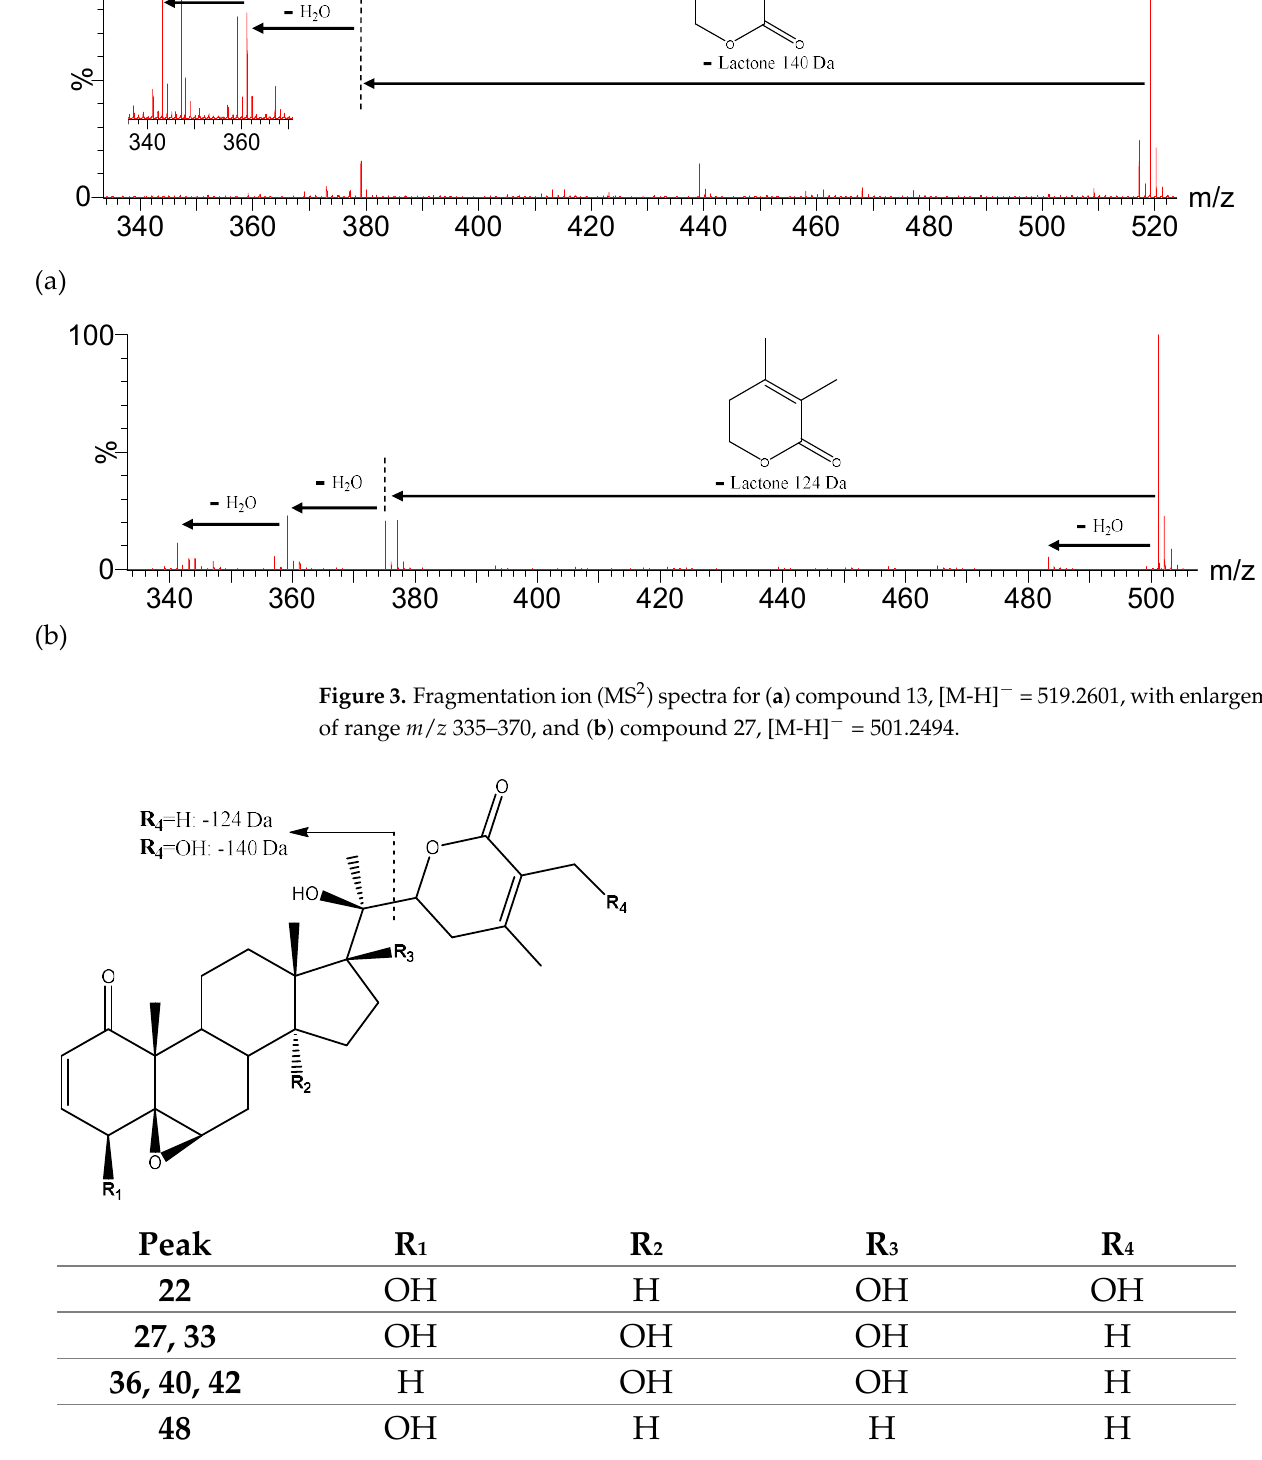
H Figure 4. Structure and fragmentation of withanolide D derivatives 22 and 48.